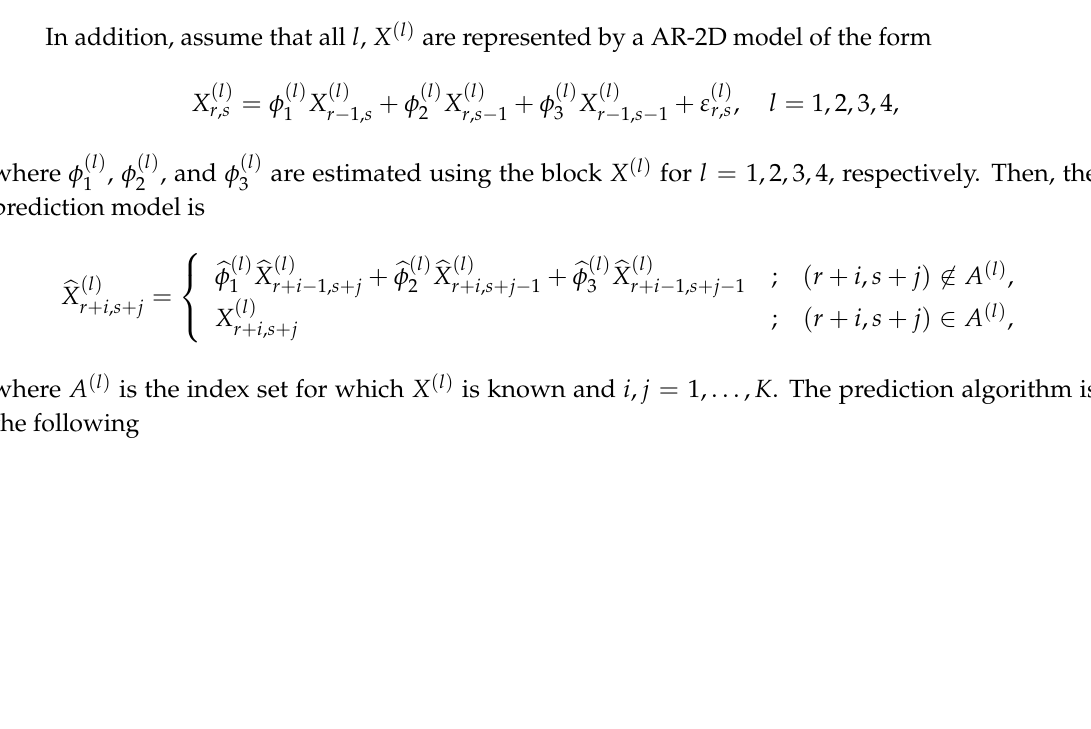
Figure A1. Block of missing